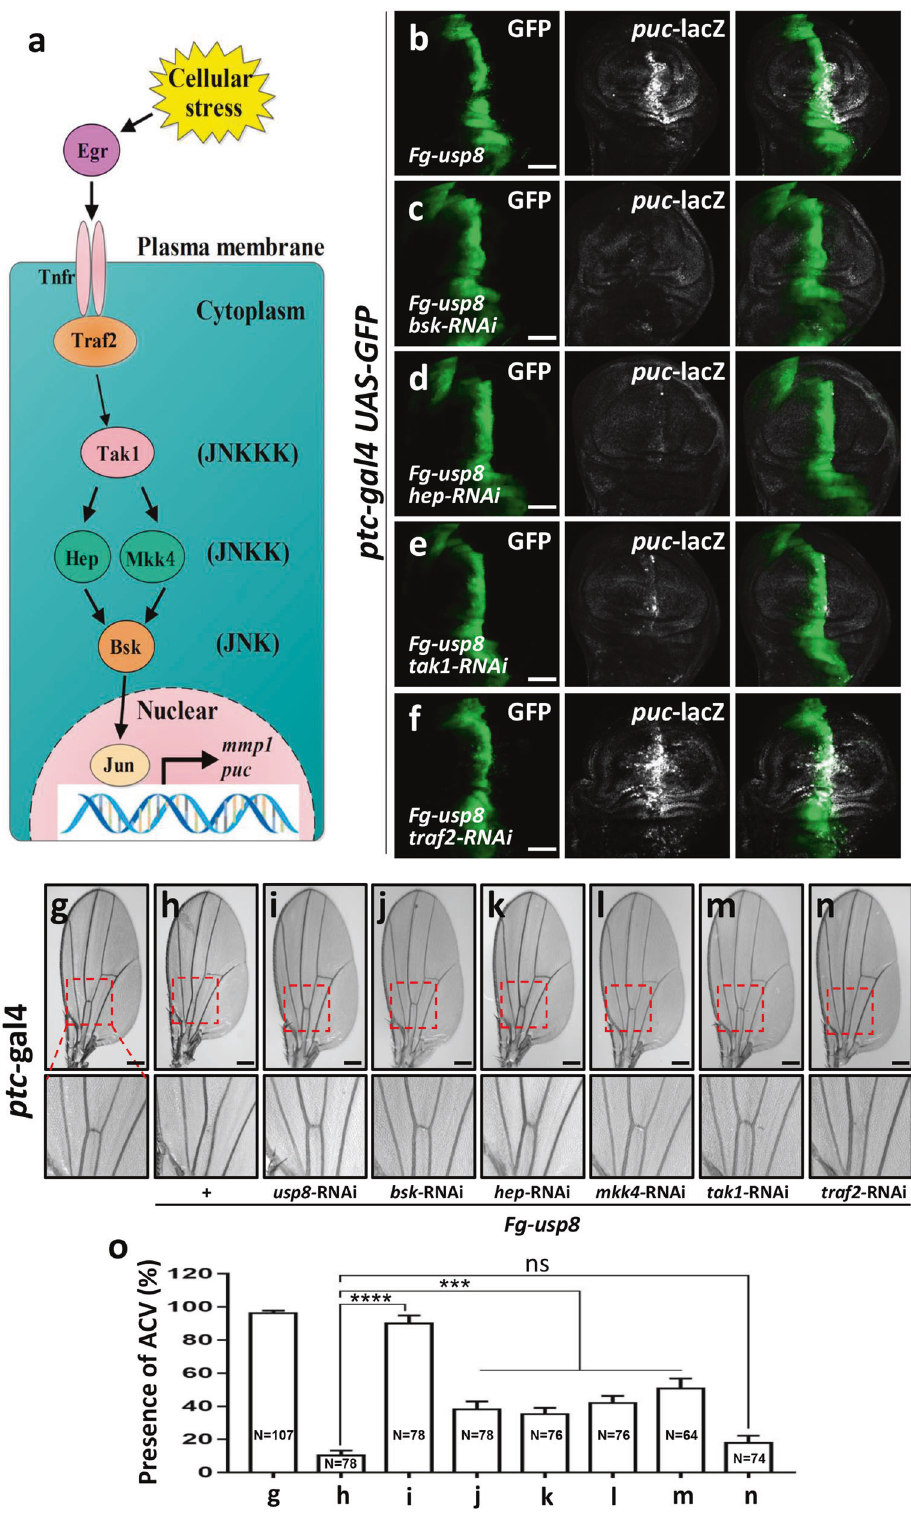
polyubiquitination on Tak1 is required for its autophosphoryla- tion and subsequent activation [12], while K48-linked polyubi- quitination promotes proteasome-mediated Tak1 degradation [30]. Since the previous report has shown that Usp8 is capable of removing both K48- and K63-linked polyubiquitin chains